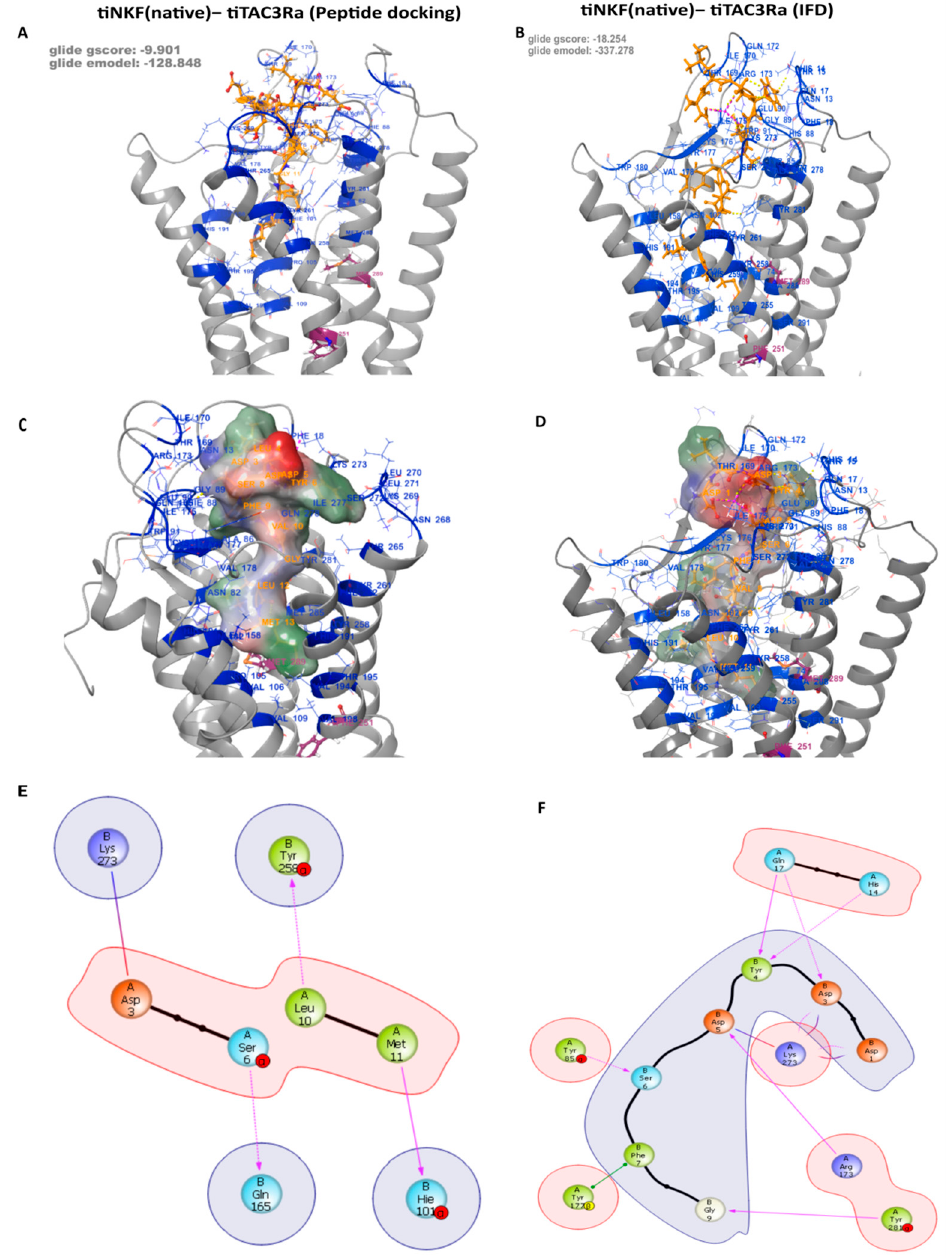
Figure 3. tiNKB/tiNKF docking on tiTac3Ra: Predicted peptide docking of native tiNKB and tiNKF on tiTac3Ra ( A , C , E ), showing tiNKB showing IFD between tiNKB-tiTacRa ( B , D , F ). The commonality is a terminal C-terminus with the amino acid sequence Phe—X—Gly—Leu—Met—NH2 docked to the hydrophobic transmembrane pocket.